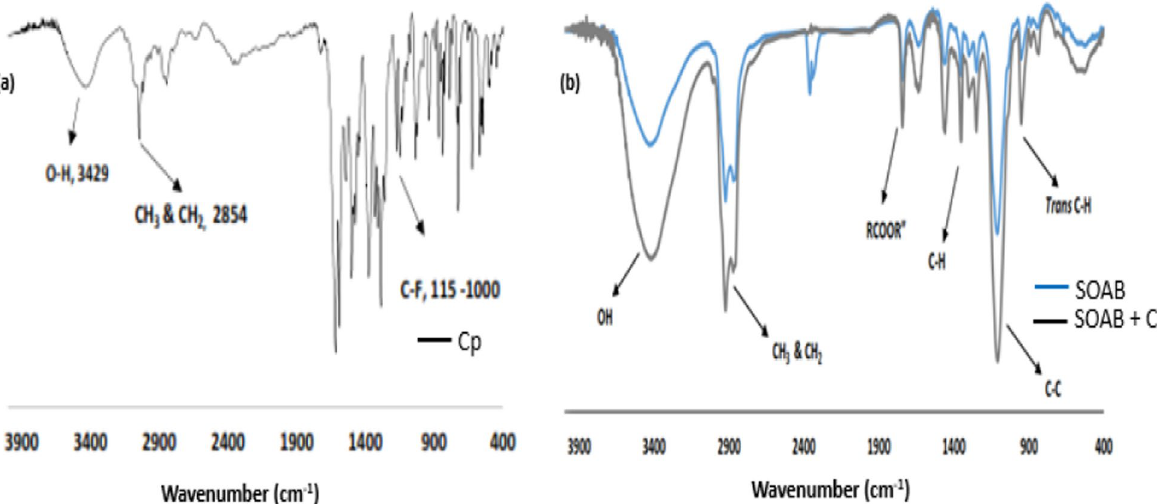
Fig. 2 FTIR Spectrum of A : Ciprofloxacin B : Sesamum indicum oil based nanoemulsion (SOAB) and Ciprofloxacin-loaded Sesamum indicum oil based nanoemulsion (SOAB